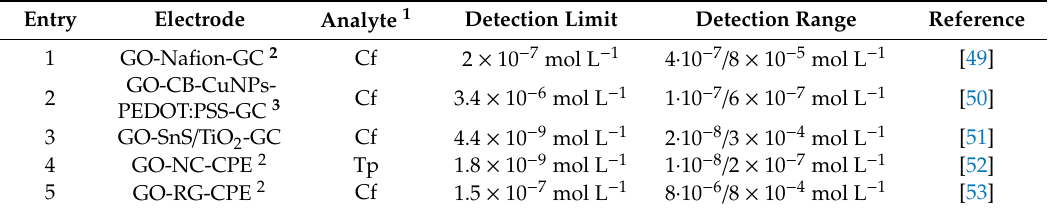
Table 3. Schematic overview on the use of GO in electrochemical sensors for natural methylxanthynes (see